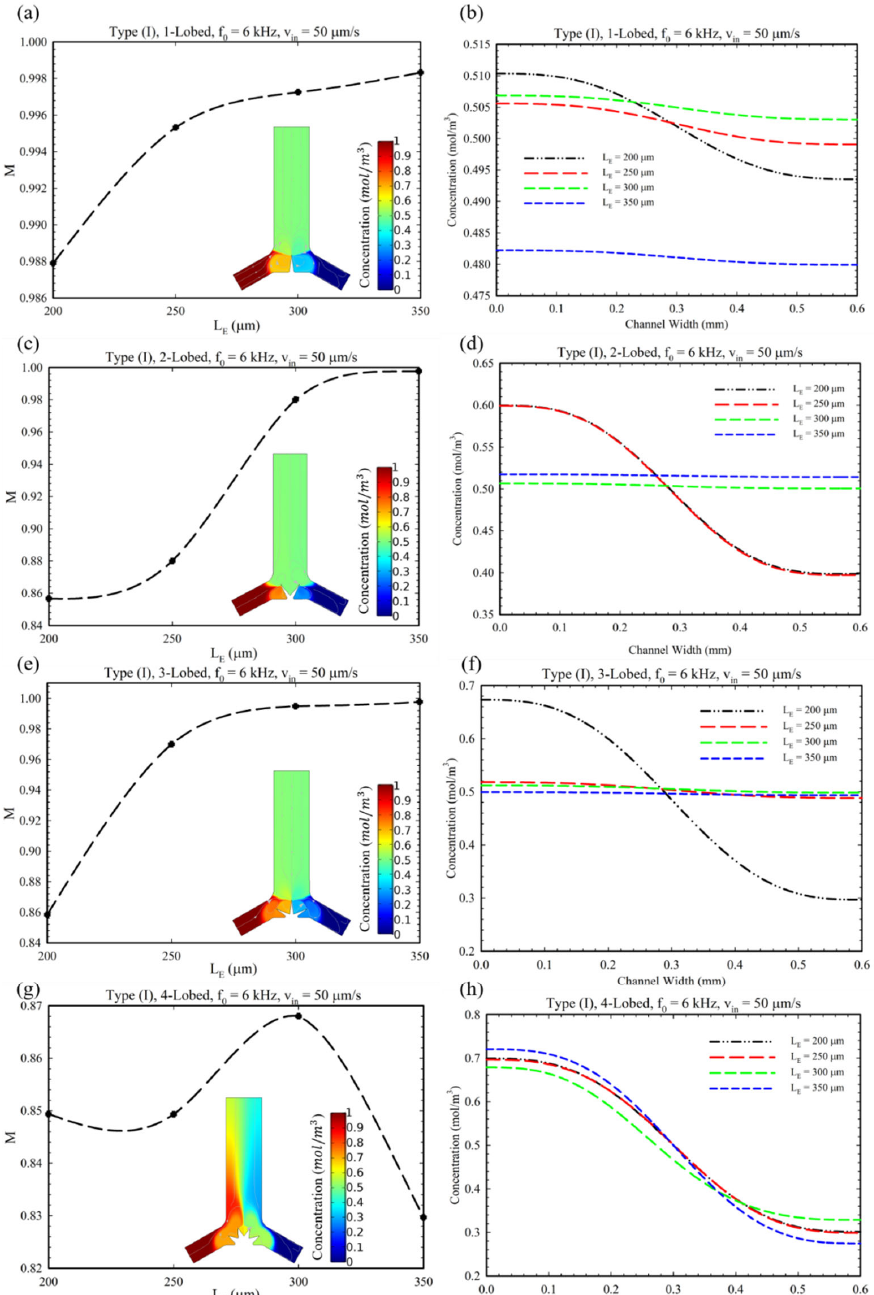
Figure 5. ( a , c , e , g ) The diagram of changes in MI for different lengths ( L E ) for Type I, II, and III configurations and multi-lobed structures. ( b , d , f , h ) The concentration profile of solute at the outlet of microchannel for different multi ‐ lobed structures.